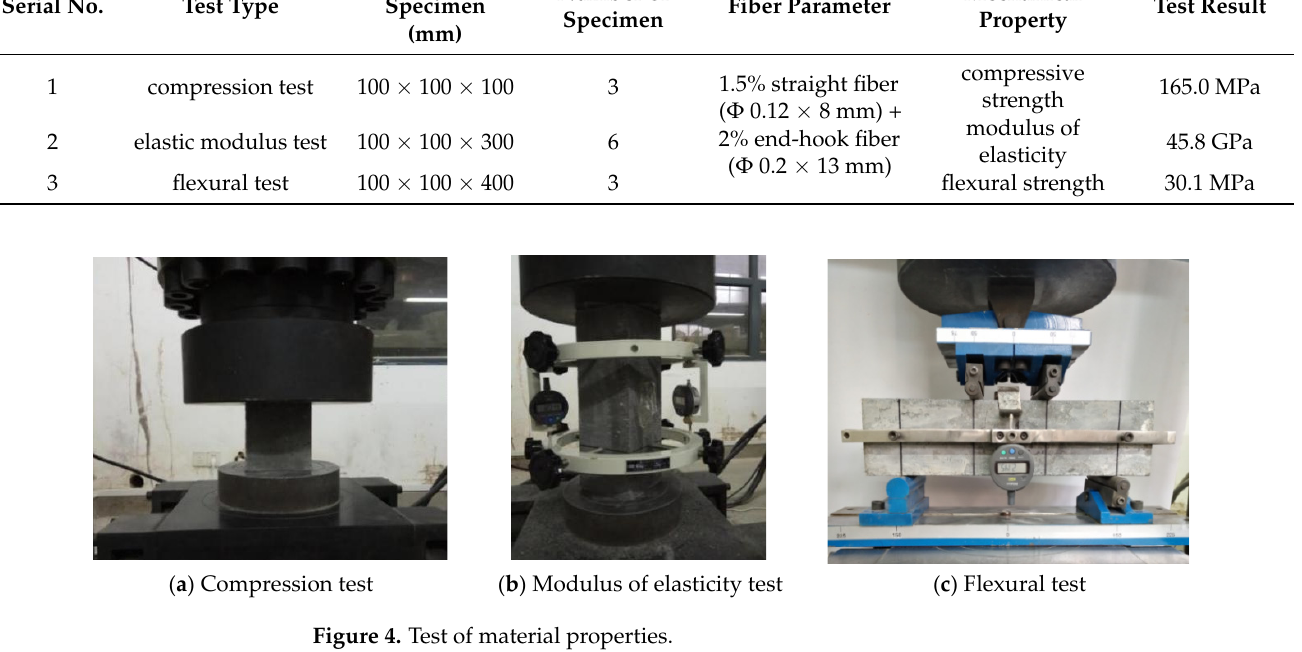
Table 3. Mechanical properties of UHPFRC.